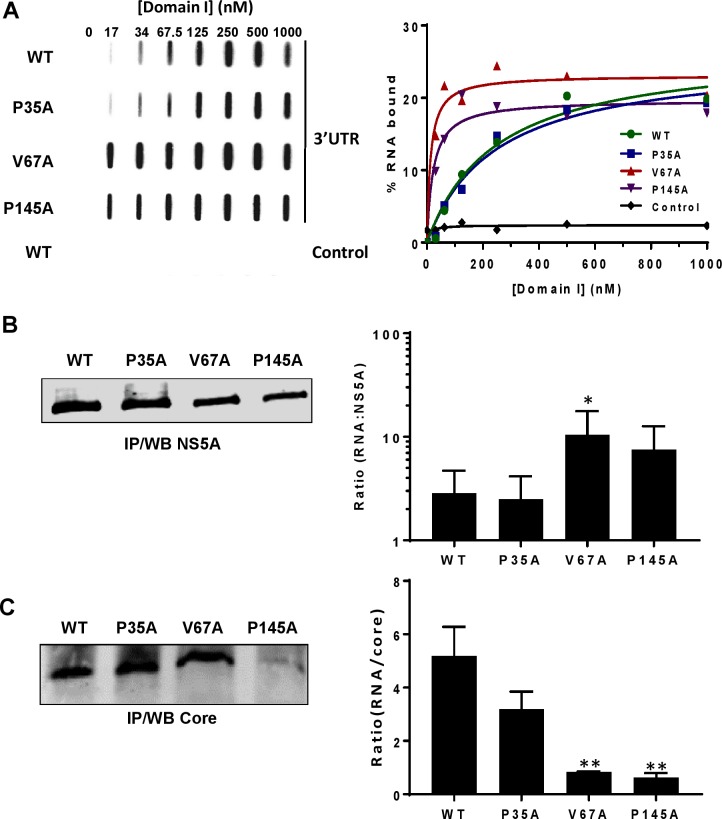
Residues at positions V67 and P145 of domain I are involved in NS5A RNA binding.A Representative slot blot analysis of RNA-protein complexes captured on nitrocellulose membrane in a filter binding assay using increased amounts of purified His-tagged NS5A domain I (S6 Fig), and a constant amount of 32P-labelled HCV 3’UTR (or control RNA [32]). % RNA bound is shown graphically, quantified by phosphoimaging analysis. B Huh7.5 cells were electroporated with in vitro transcripts of mJFH-1 WT or the indicated mutants. Cells were lysed at 72 h.p.e. and NS5A was immunoprecipitated from cell lysates. After washing the beads were subjected to analysis by Western blot and RNA extraction. qRT-PCR were performed to quantify the level of (+) genome RNA bound to NS5A. The graph on the right shows the ratio of RNA copies to NS5A (n = 2). C As B but in this case Core was immunoprecipitated using a rabbit polyclonal anti-Core antibody. ** indicates significant difference (P<0.01) from WT.